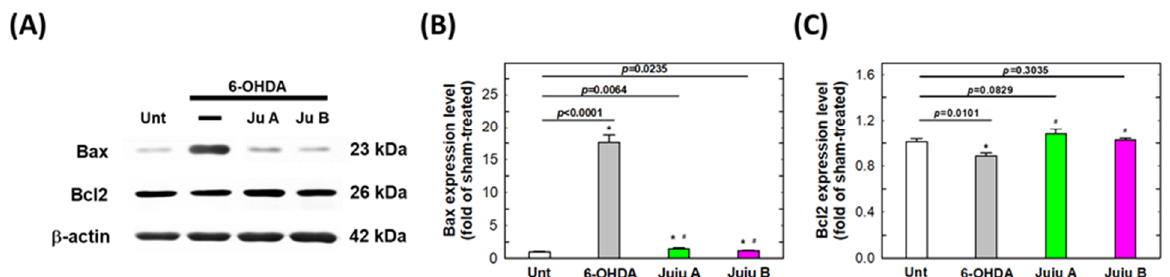
Figure 11. The signaling patterns altered by the treatments of 6-OHDA and jujubosides. ( A ) Western blotting was conducted specifically for Bax and Bcl2. ( B ) Quantitative analysis of the intensities of Bax bands. ( C ) Quantitative analysis of the intensities of Bcl2 bands. β-actin served as an internal loading control in each repeat of experiment. * significant different from untreated group. # significant different from the 6-OHDA treated group.